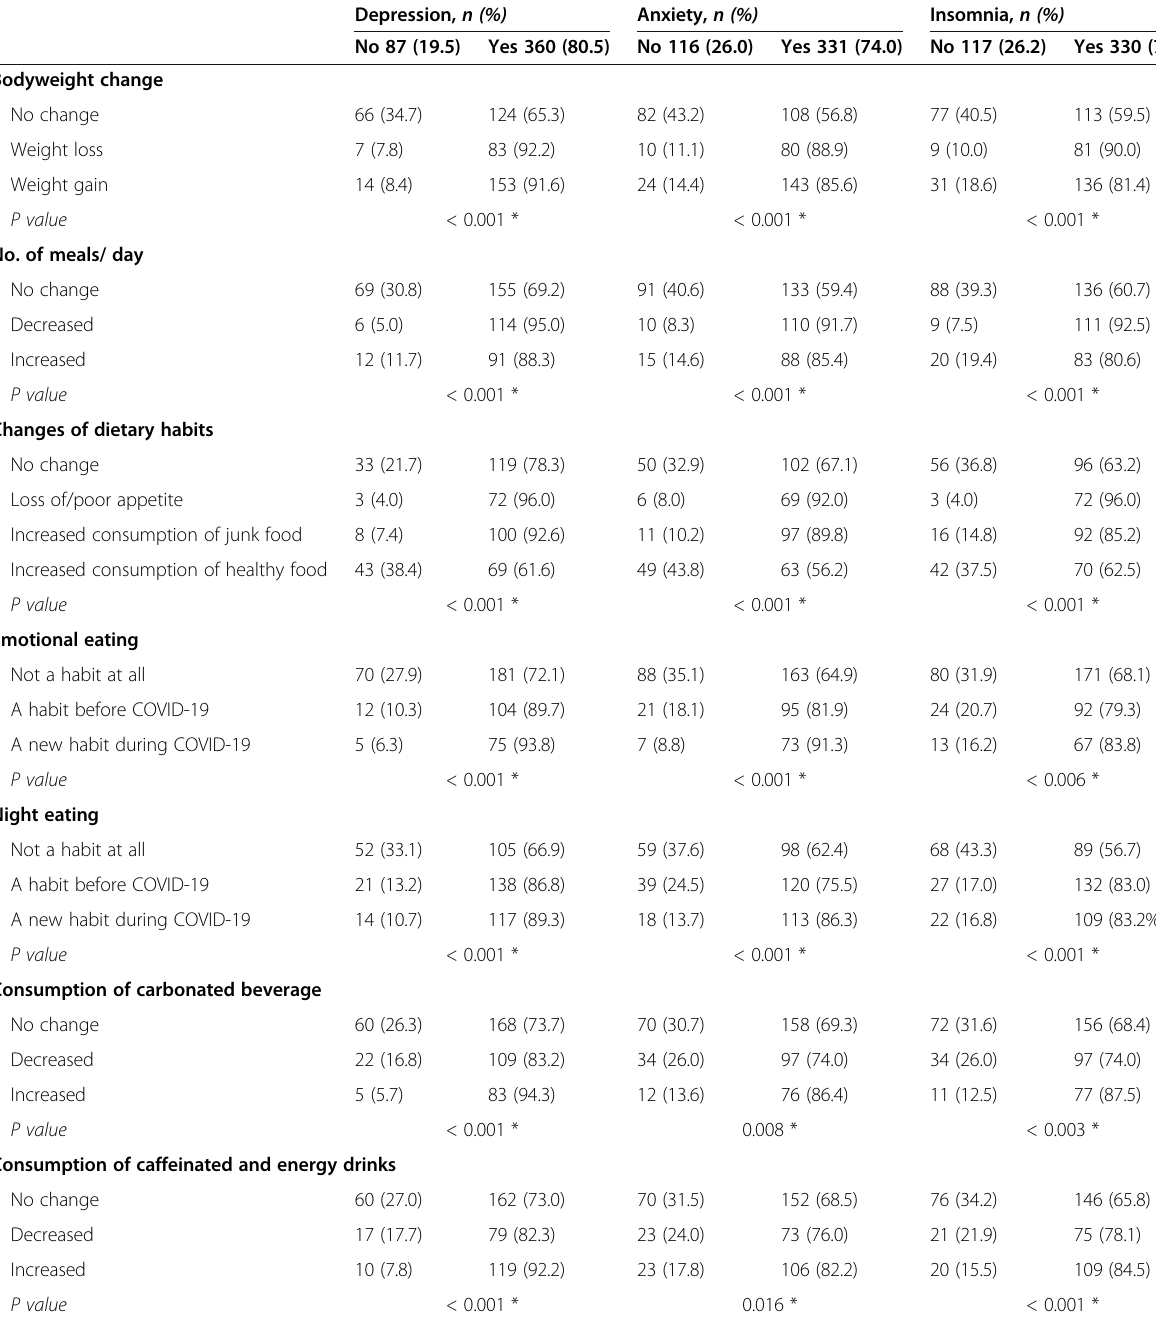
Table 4 Association between dietary changes during COVID-19 and depression, anxiety, and insomnia symptoms among the participants ( n = 447) Depression, n